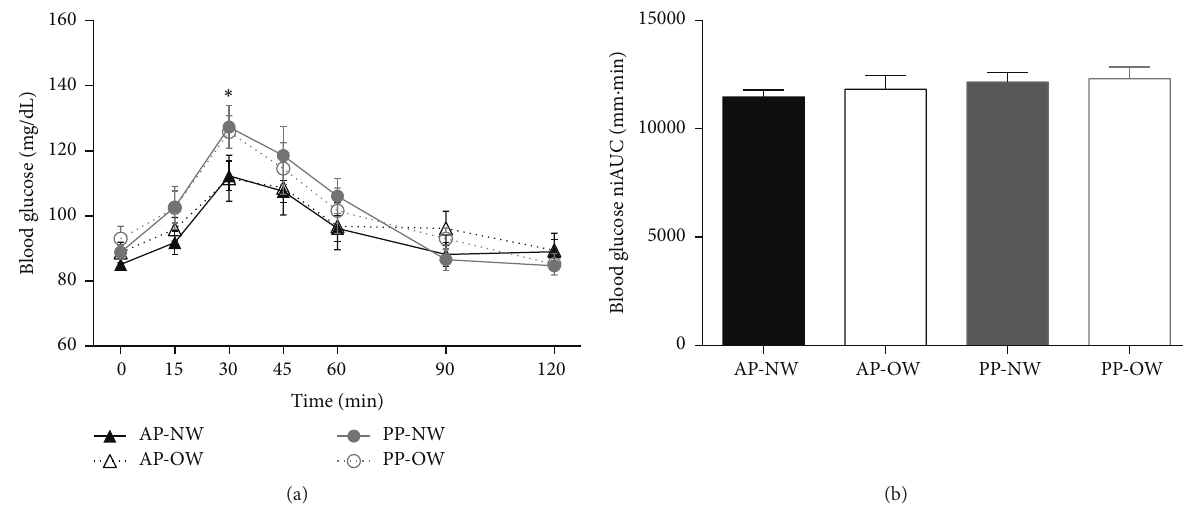
Figure 3: Glucose response to the test breakfasts. (a) Glucose response to the test breakfasts over time. (b) Glucose net incremental area under the curve (niAUC). Values expressed as means ± SEM. ∗ indicates that blood glucose values for AP were significantly different than PP ( 𝑃 < 0.05 ). AP: animal protein; NW: normal weight; OW: overweight; PP: plant protein.